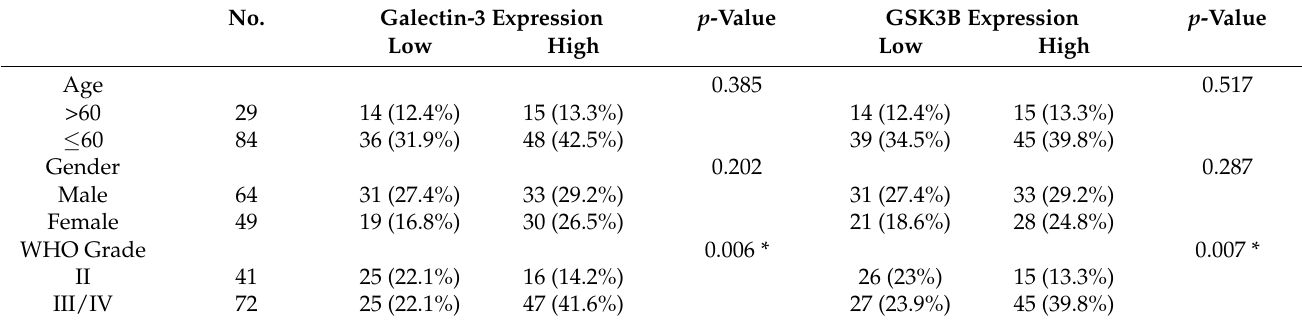
Table 1. Galectin-3/GSK3B expression correlated with clinicopathologic parameters in